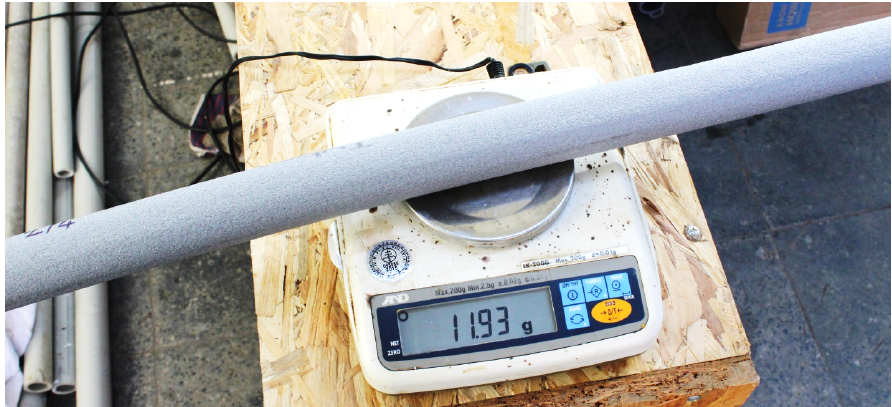
Figure 3. Weighing of the meter sections after application of the dispersion oil